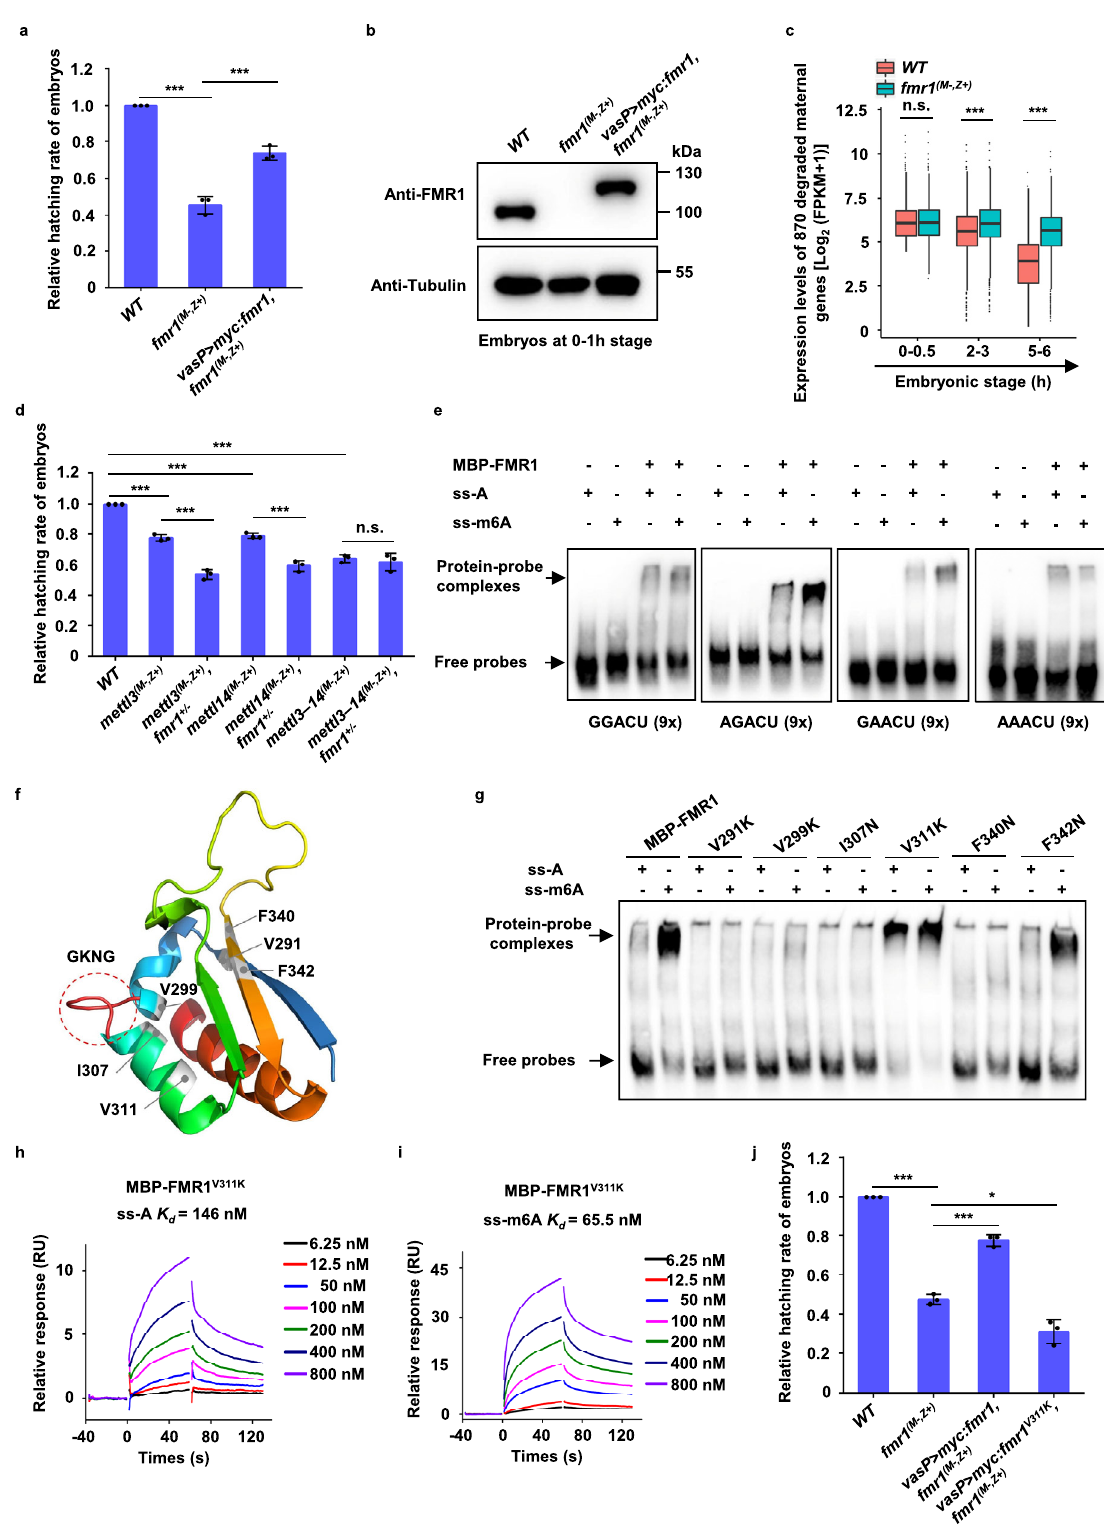
interest, we noted that the KH2 domain in FMR1 contains a hydrophobic network around the “ GxxG ” loop, as reported in the previous structure study 42 , and con fi rmed by our alignment and modeling analysis (Fig. 2f and Fig. S7a). Thus, we asked whether this hydrophobic network is critical for differential recognition of the m6A-modi fi ed and unmodi fi ed RNAs by FMR1. To test this possibility, we generated a series of FMR1 mutant proteins